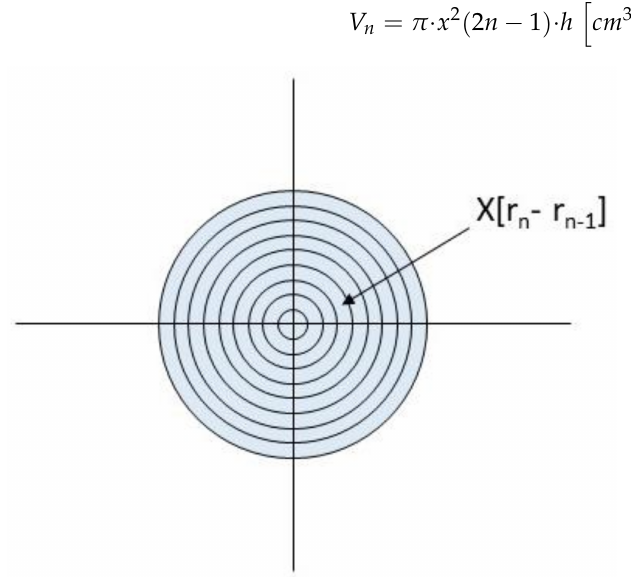
Figure 2. Sample model used in